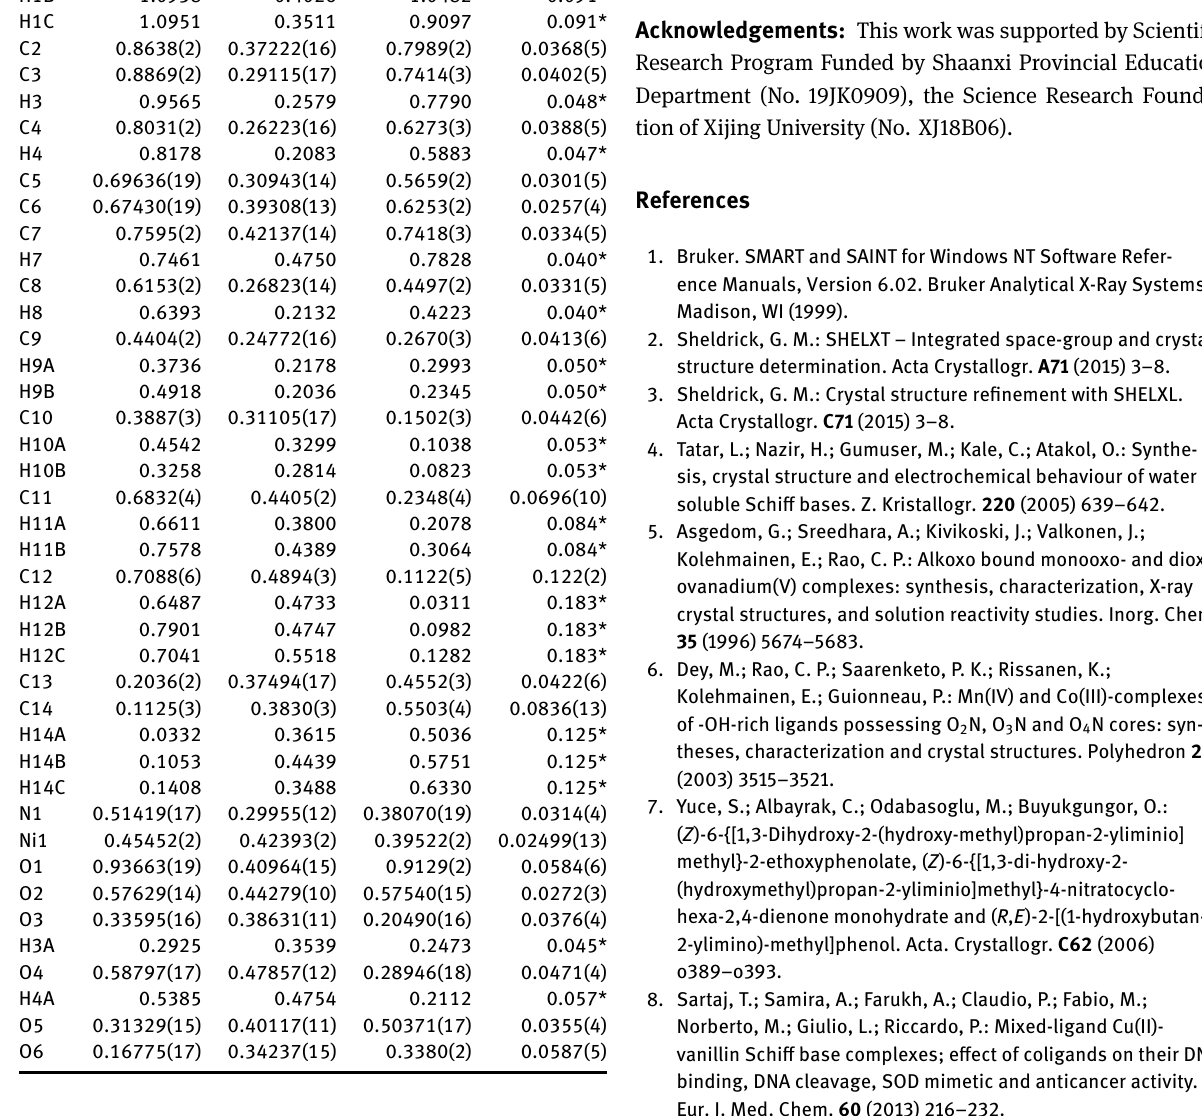
nickel atoms, two acetate groups and two ethanol molecules, arranged around an inversion center. The coordination of Ni